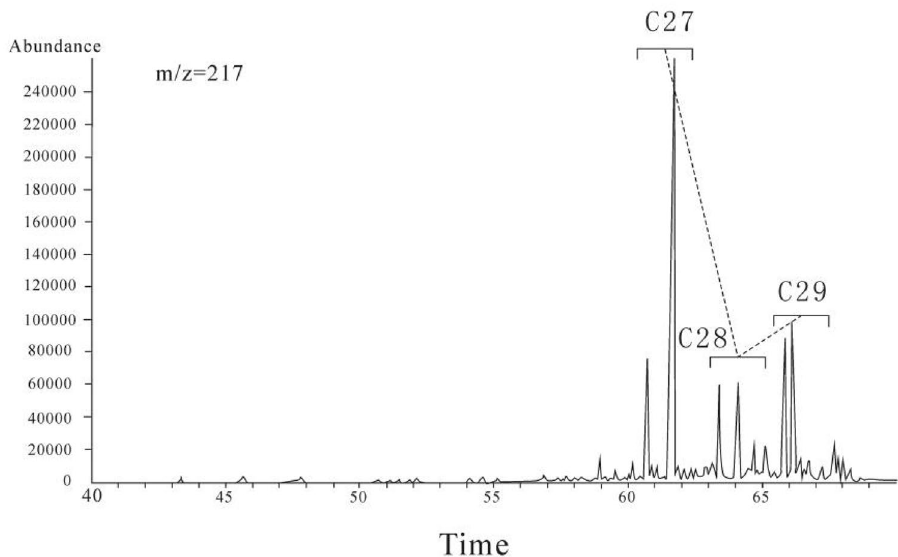
Figure 4. MS with m/z = 217.